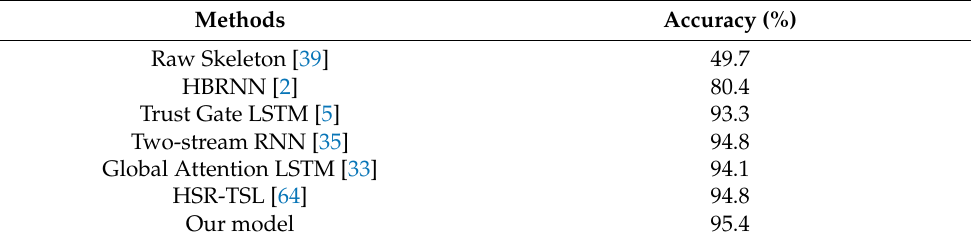
Table 5. Recognition accuracy (%) achieved with previous methods using SUB Kinetic Interaction dataset.